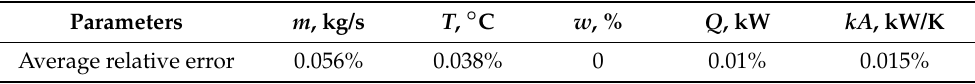
Table 3. Average relative error of each parameter of the absorption